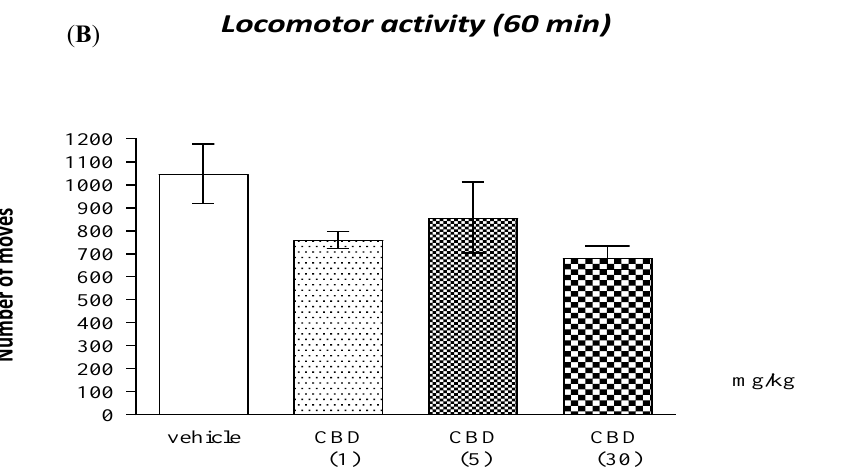
Figure 3. Effects of CBD on locomotor activity. The data are shown as the means ± SEM; photocell beam breaks of mice measured immediately after injection for 30 min ( A ) and 60 min ( B ); n = 8 – 10.